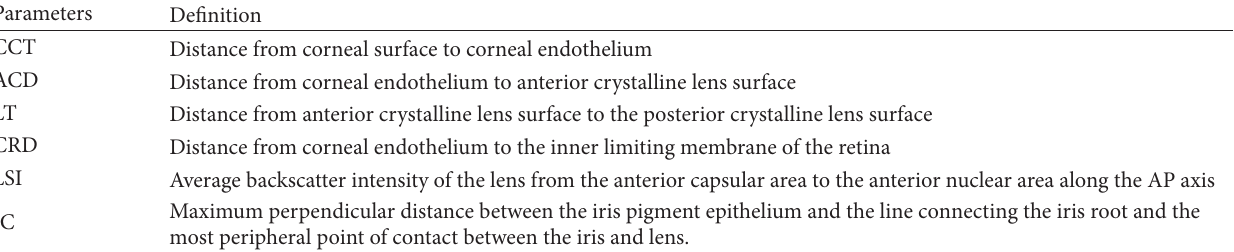
Table 2: Definition of parameters.